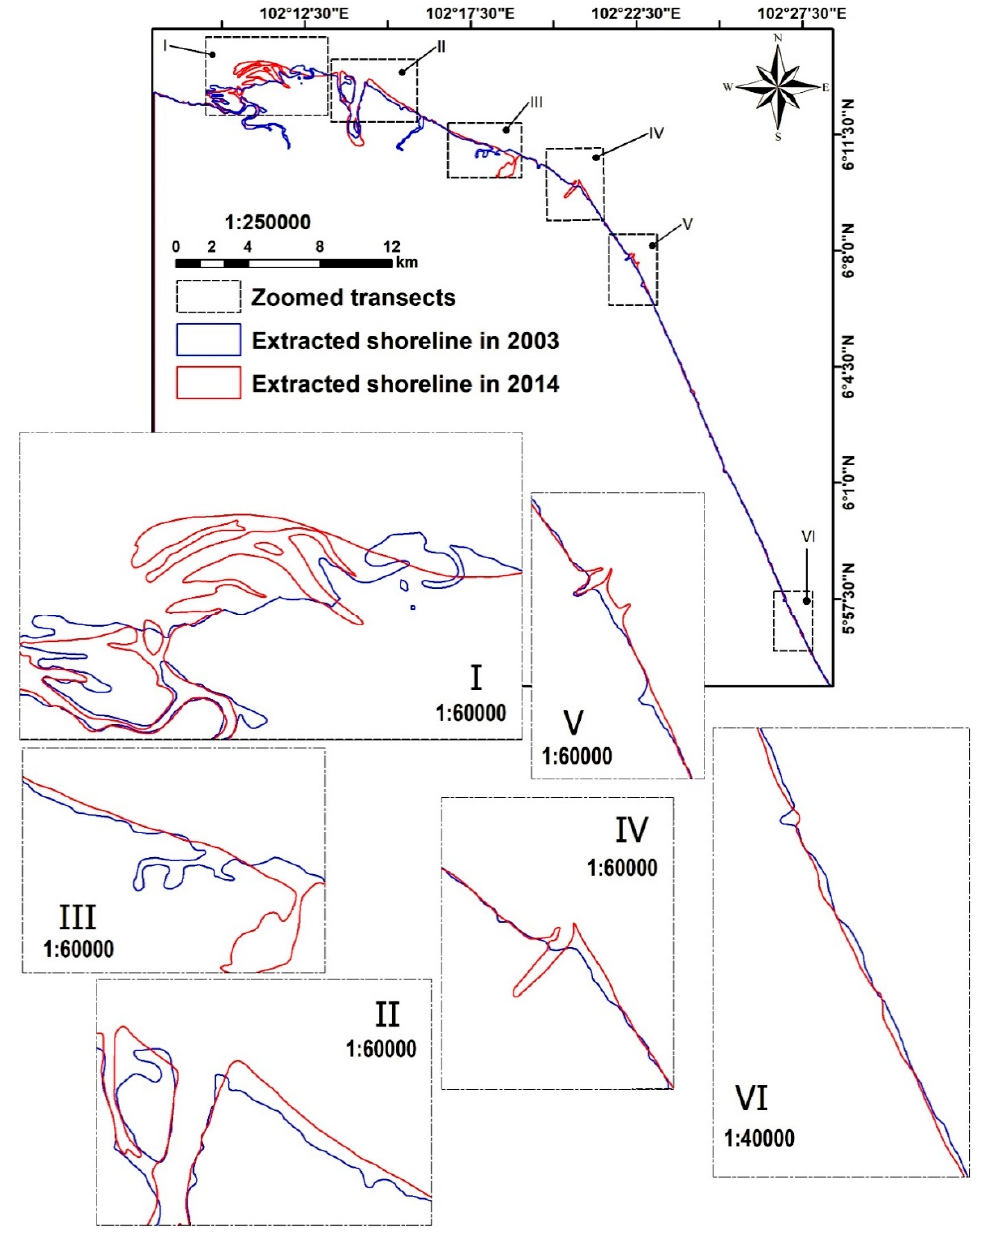
Figure 9. Shoreline changes from 2003 to 2014.